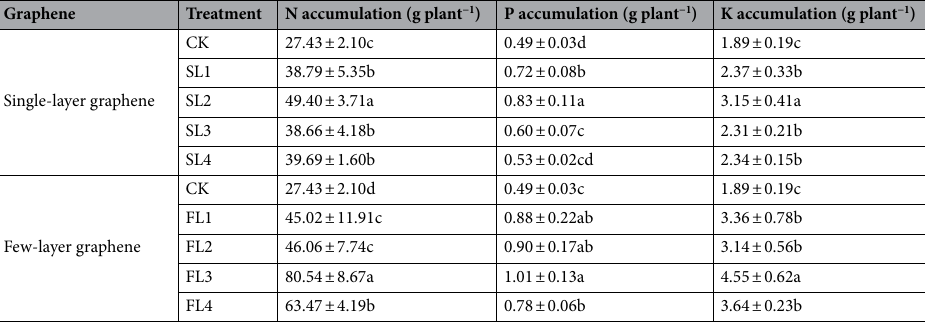
Table 4. Effect of different graphene concentration and type on plant nutrients accumulation. CK. 0 g kg −1 single-layer graphene and 0 g kg −1 few-layer graphene; SL1 and FL1. 25 g kg −1 single-layer graphene and 25 g kg −1 few-layer graphene; SL2 and FL2. 50 g kg −1 single-layer graphene and 50 g kg −1 few-layer graphene; SL3 and FL3. 100 g kg −1 single-layer graphene and 100 g kg −1 few-layer graphene; SL4 and FL4. 150 g kg −1 single-layer graphene and 150 g kg −1 few-layer graphene; error bars indicate ± standard deviation. Different letters above error bars indicate significant difference between treatment ( p < 0.05, LSD test).